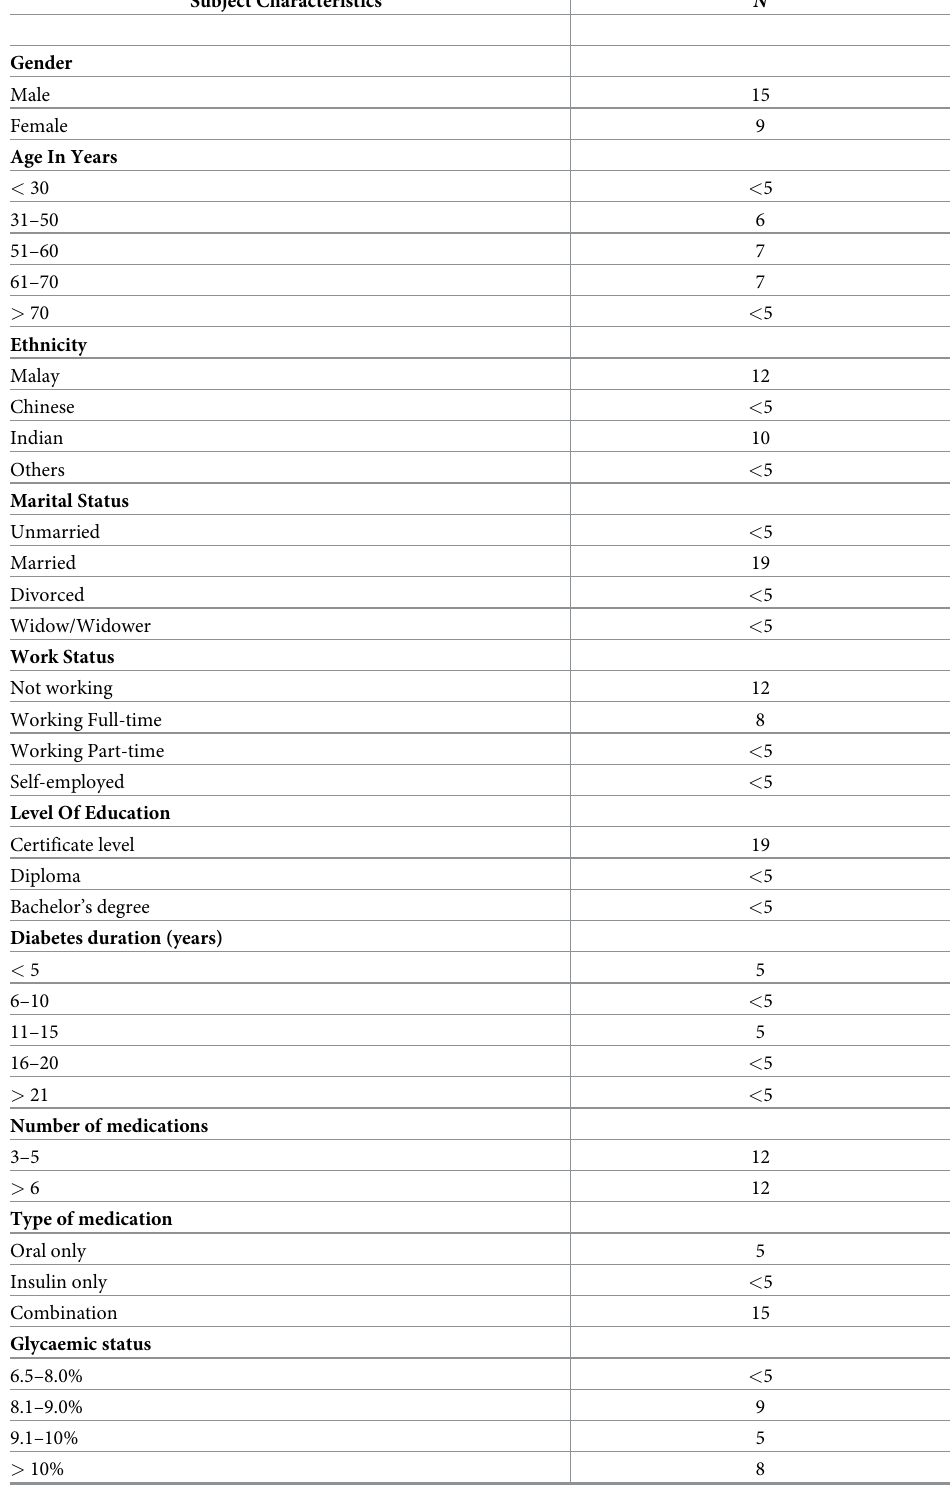
Table 1. Demographic details of T2D patients of the